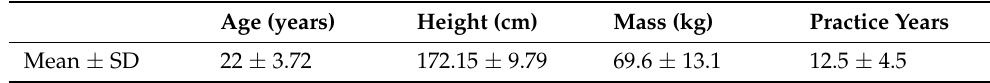
Table 1. Volunteers’ relevant characteristics (n =